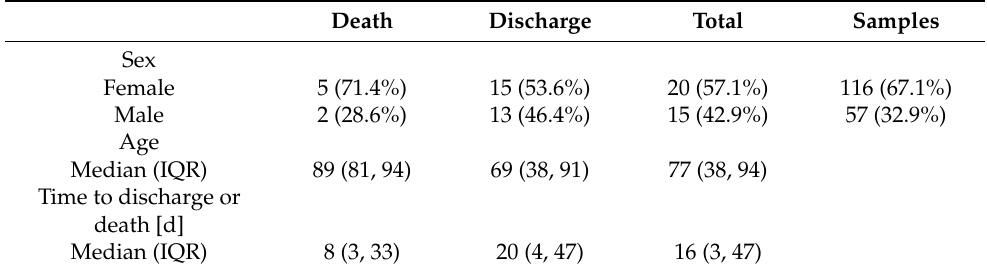
Table 1. Characteristics of the COVID-19 patients and serum samples contributing to this study.